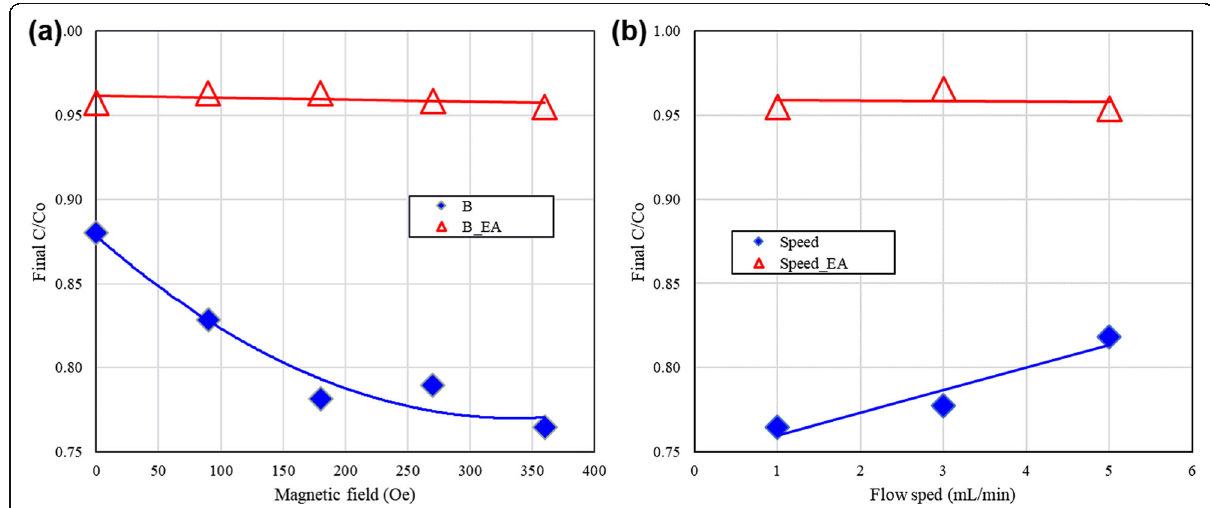
Fig. 4 Experimental results. a Photocatalytic degradation of MO from the application of various magnetic fields with and without EA. b Effects of flow speed in the magnetic field-enhanced photocatalytic reaction in the micro optofluidic chip